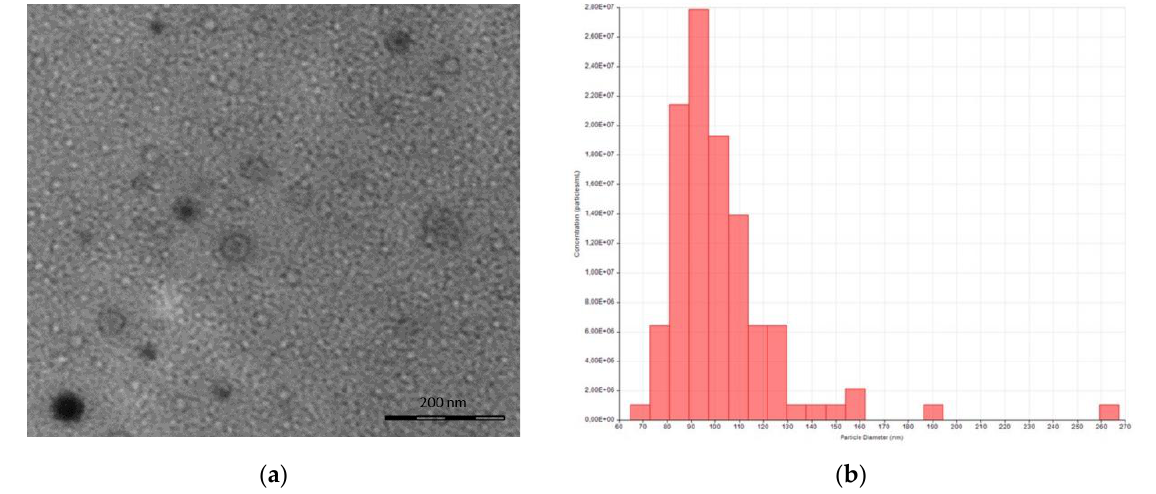
Figure 5. HUVEC-sEV isolation. ( a ) Representative TEM image. ( b ) Size distribution and concentration using tunable resistive pulse sensing instrument qNano (iZON Science, Oxford, UK). Average hydrodynamic diameter was 102 ± 24.9 nm, mode 93 nm, d10 83 nm, d50 97 nm, d90 123 nm. Average concentration was 2.21 × 10 7 particles/mL.